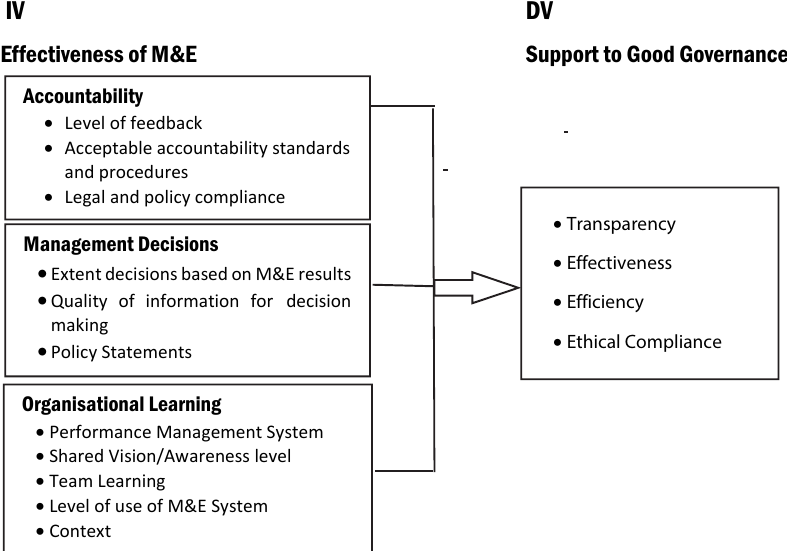
Figure 1 IV DV Effectiveness of M&E Support to Good